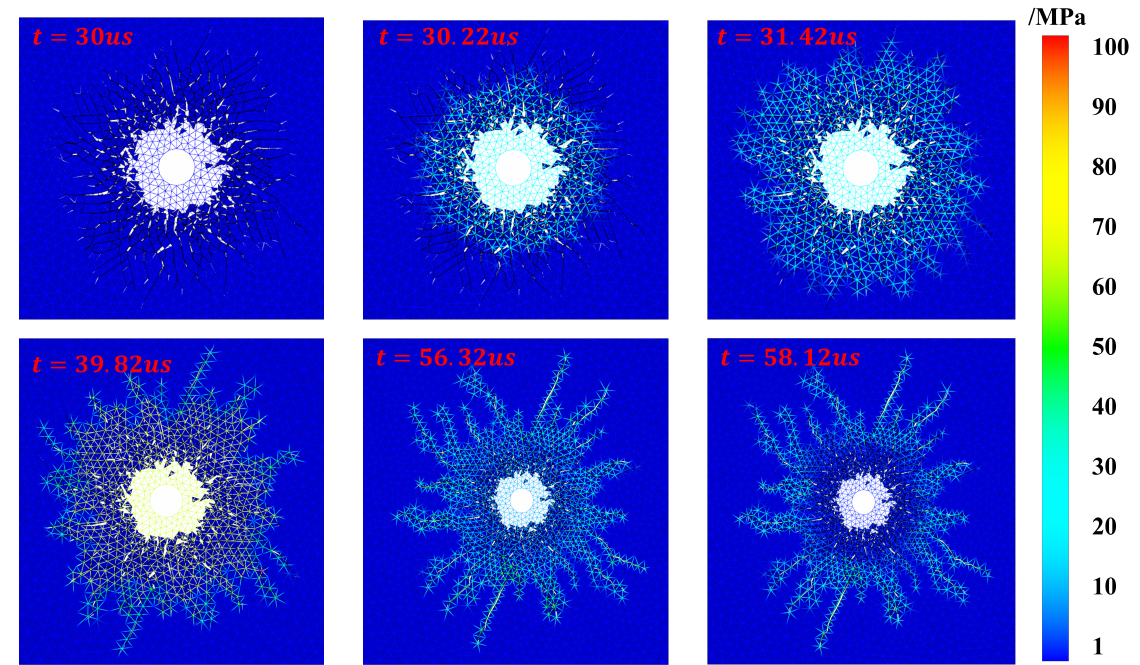
Figure 7. Pressure of explosive